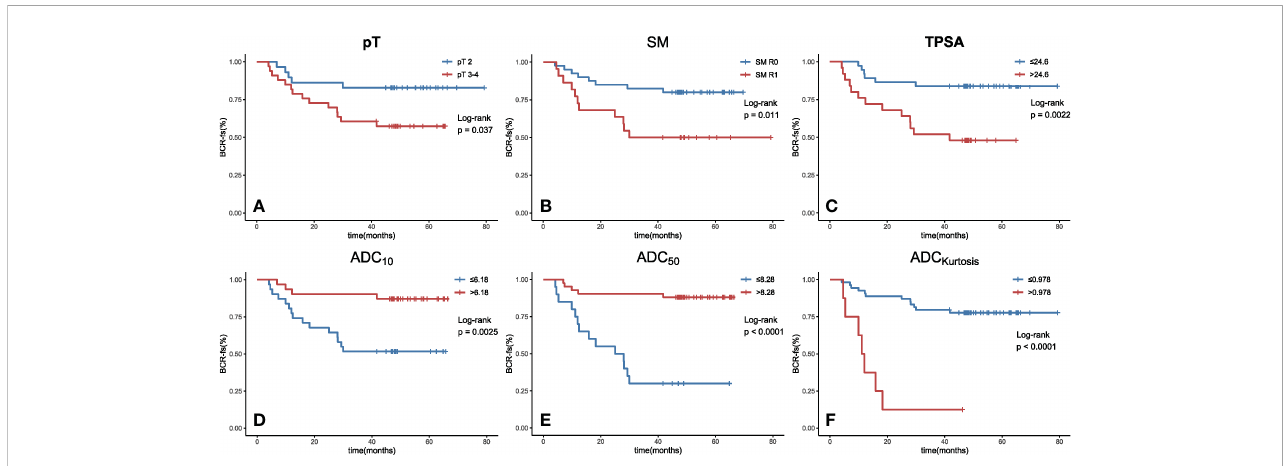
FIGURE 2 Kaplan − Meier curves with log-rank test for BCR-fs based on (A) pT, (B) SM, (C) TPSA, (D) ADC 10 , (E) ADC 50 and (F) ADCkurtosis. All of these parameters were signi fi cant prognostic factors. (BCR-fs, biochemical recurrence-free survival; pT, pathological T staging; SM, surgical margin; TPSA, total prostate- speci fi c antigen; ADC, apparent diffusion coef fi cient; the values of ADC 10 , ADC 50 are given in units of ×10 -4 mm 2 /s, the value of kurtosis is given in unit of ×10 -1 and the value of TPSA is given in unit of ×10 -1